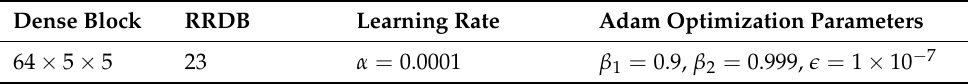
Table 1. ESRGAN model and training parameters setup